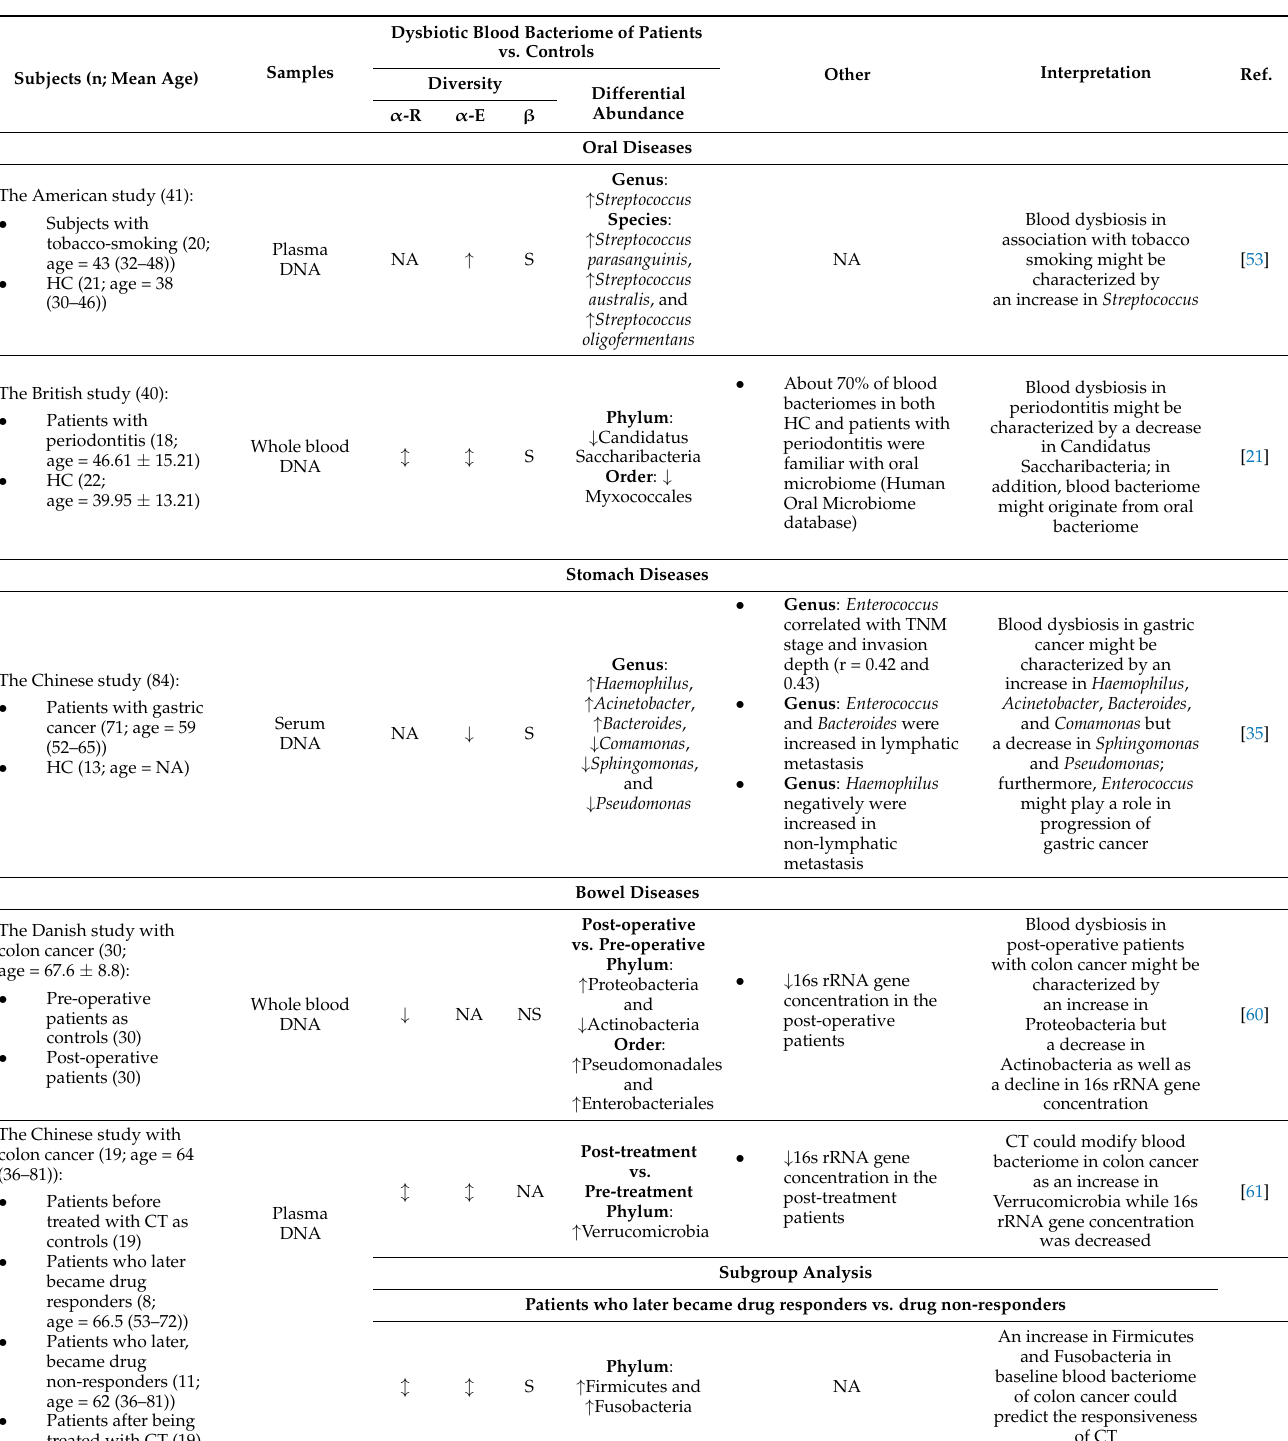
Table 4. Blood Bacteriome Dysbiosis Profiles in Oral, Gastrointestinal, and Hepatobiliary